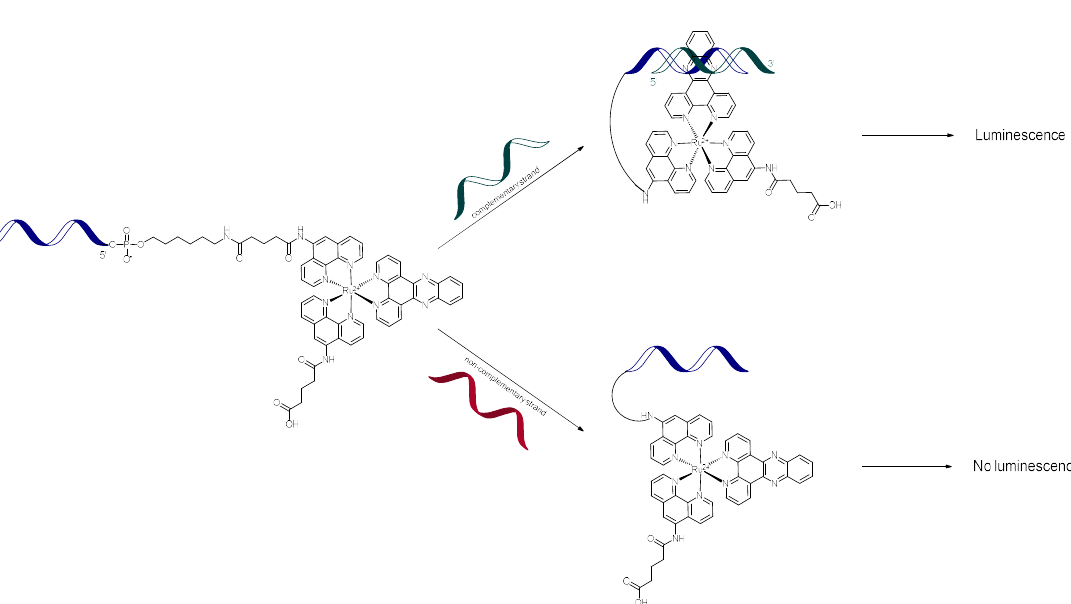
Figure 1. Diagram illustrating the occurrence of intercalation exclusively in the presence of a complementary strand [68,69].